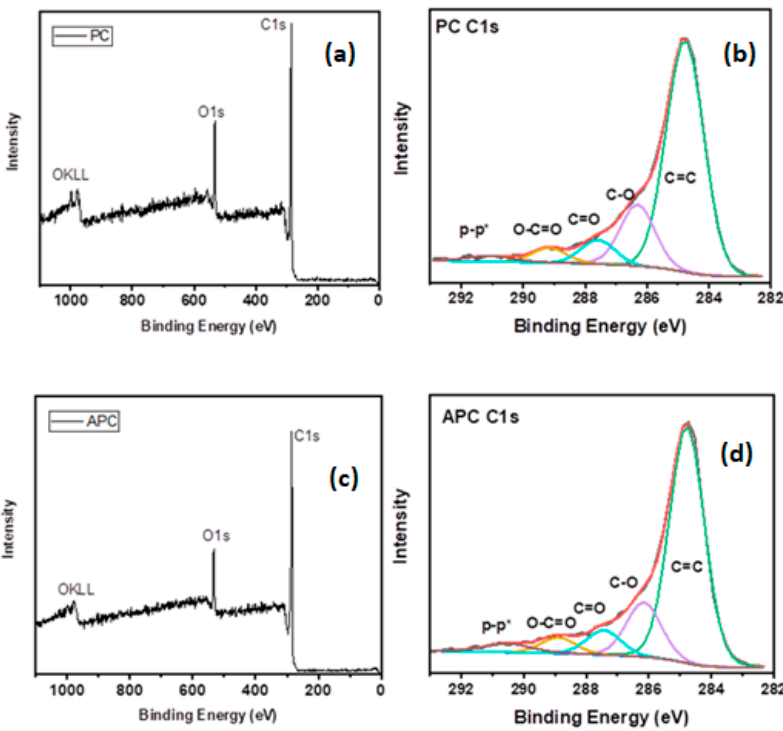
Figure 9. ( a ) XPS survey of PC material; ( b ) high resolution C1s spectra of PC material; ( c ) XPS survey of APC material; and ( d ) high resolution C1s spectra of APC material.